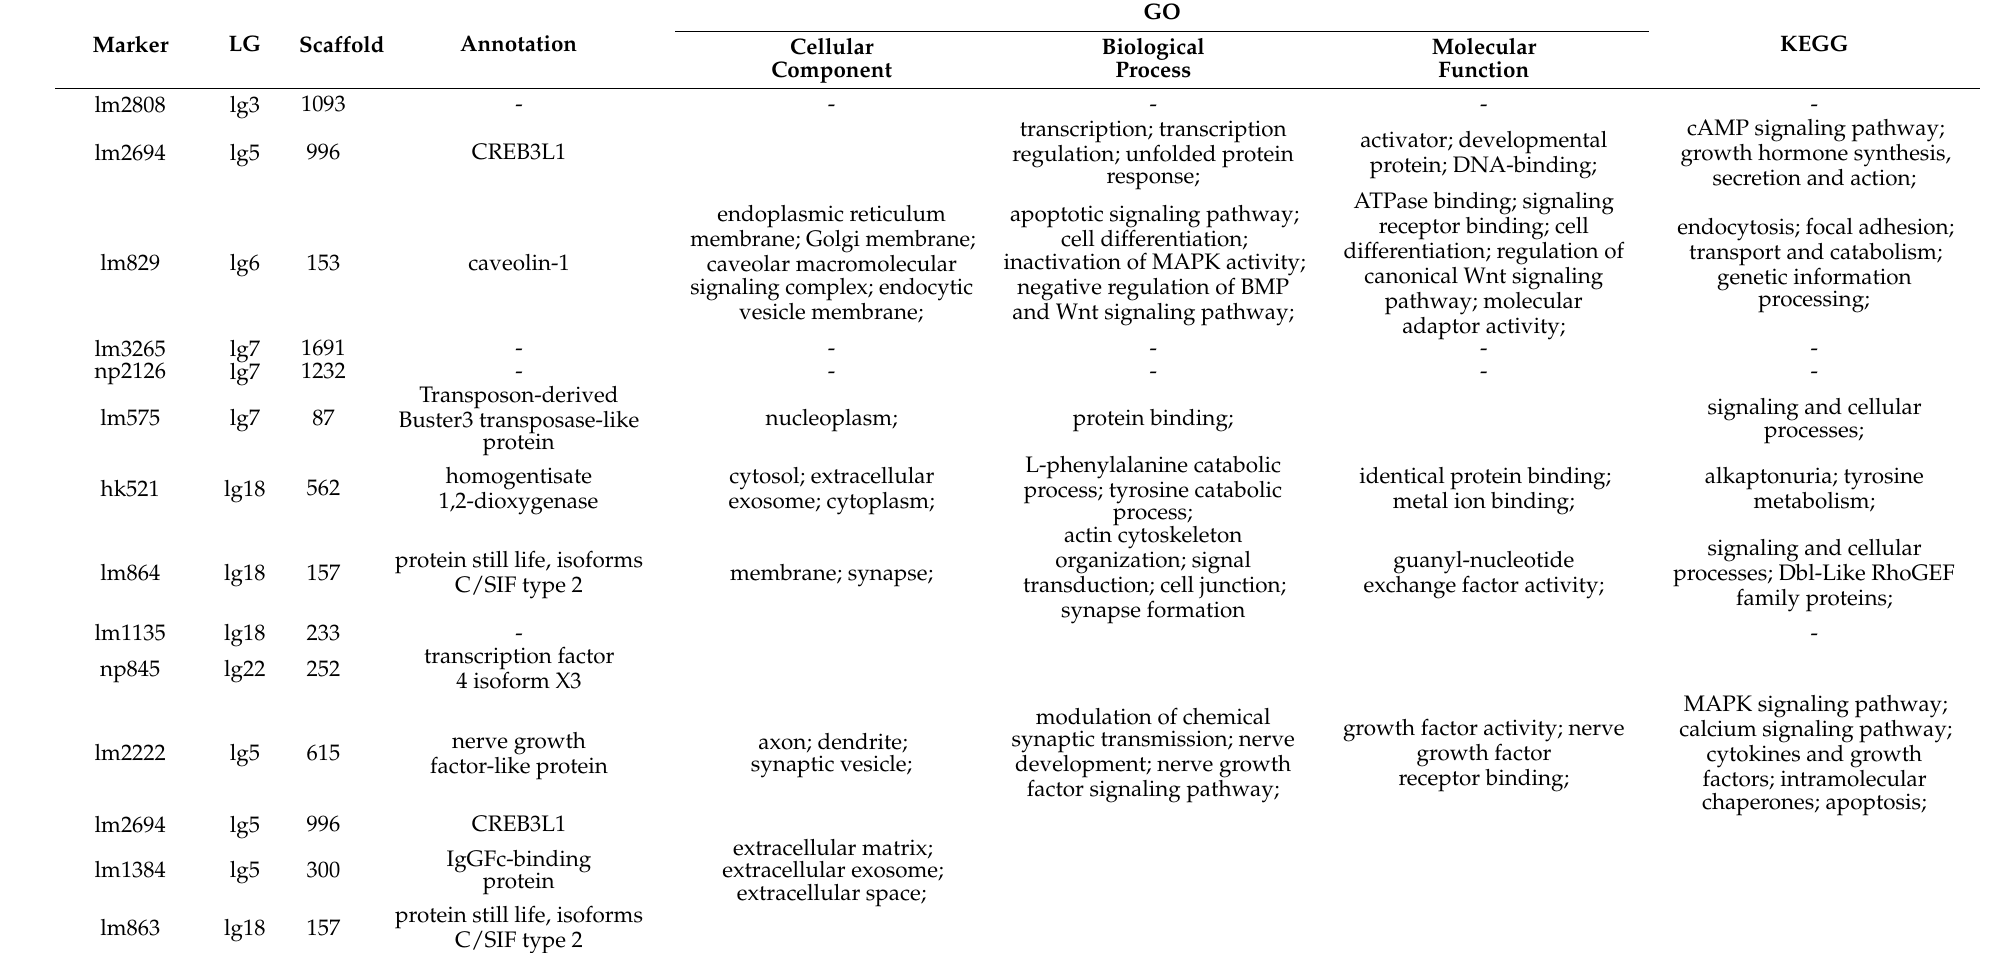
Table 4. Summary of the growth-related candidate gene from